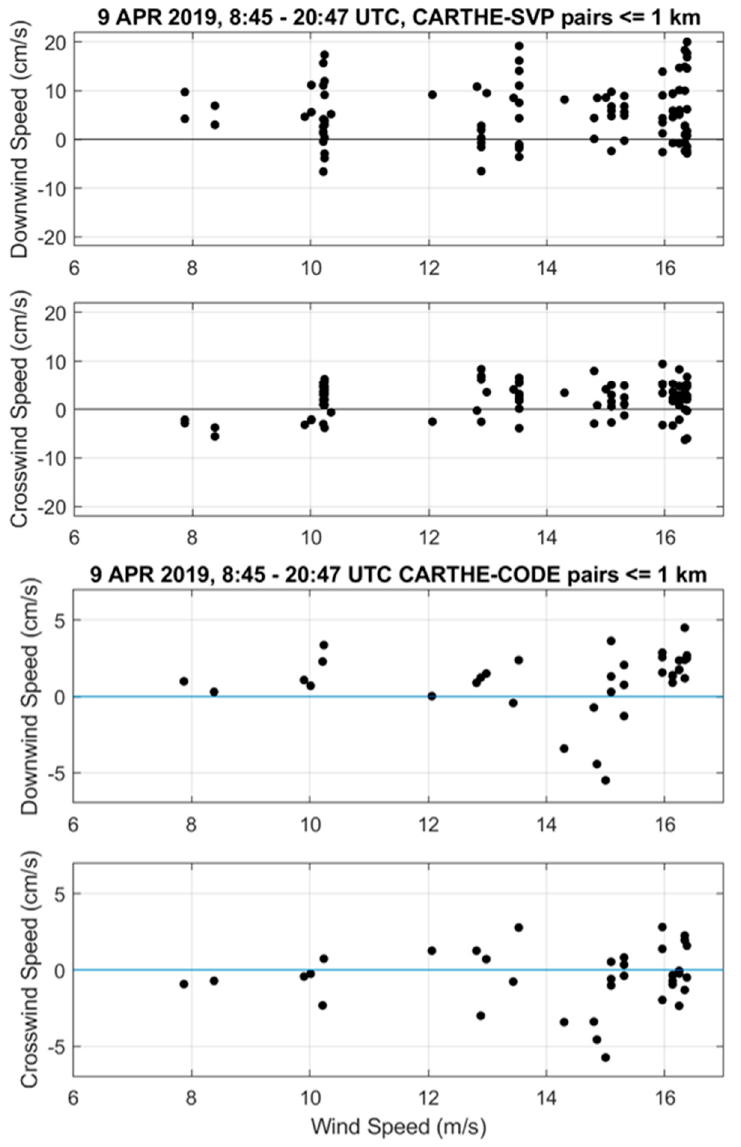
Figure 6. Down- and cross-wind components of velocity difference between CARTHE and SVP ( top panels ) and CARTHE and CODE ADCP ( bottom panels ) drifters versus wind speed on 9 April 2019 between 08:45 and 20:47 UTC.